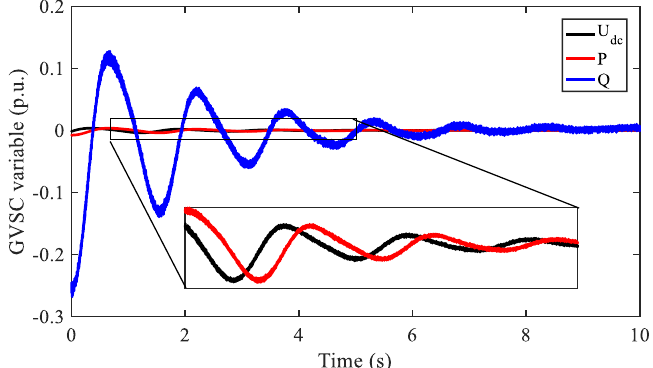
Figure 16. Measured response of port variables of GVSC. Table 5. Oscillation parameters of GVSC port variables.